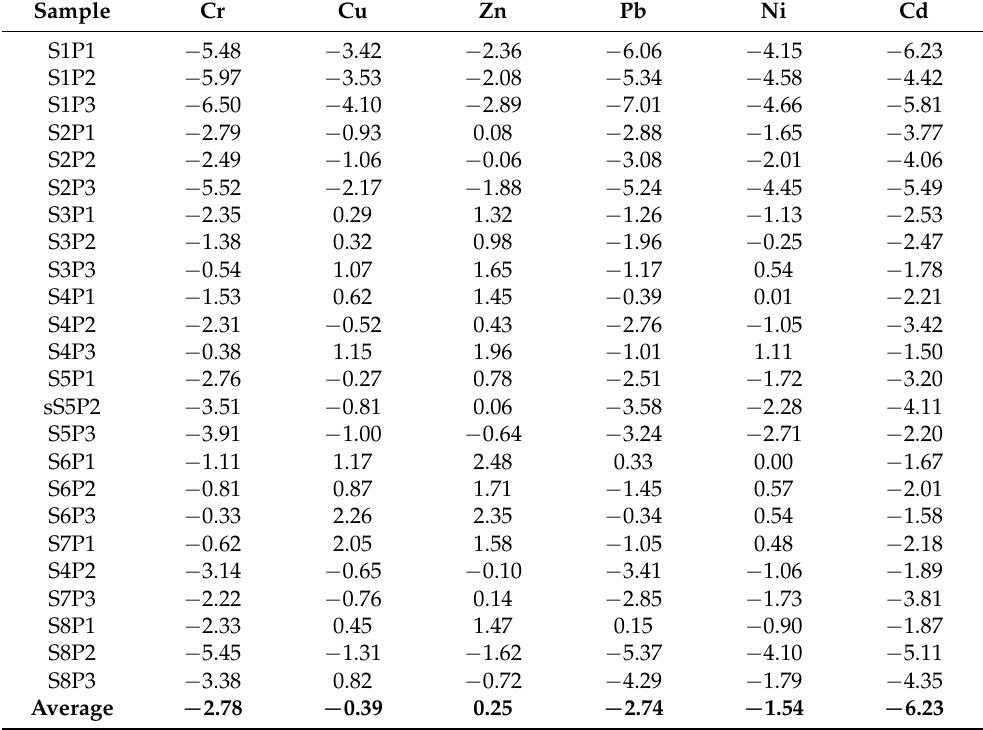
Table 6. Geoaccumulation